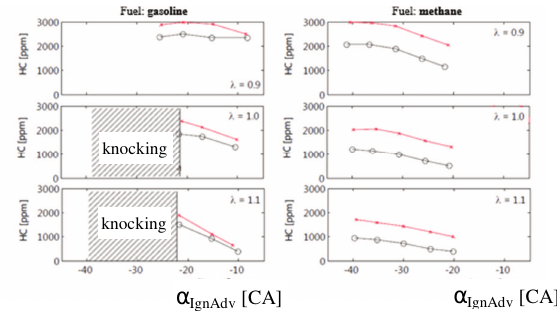
Fig. 11. Hydrocarbons concentration in the exhaust gas of petrol and methane fueled